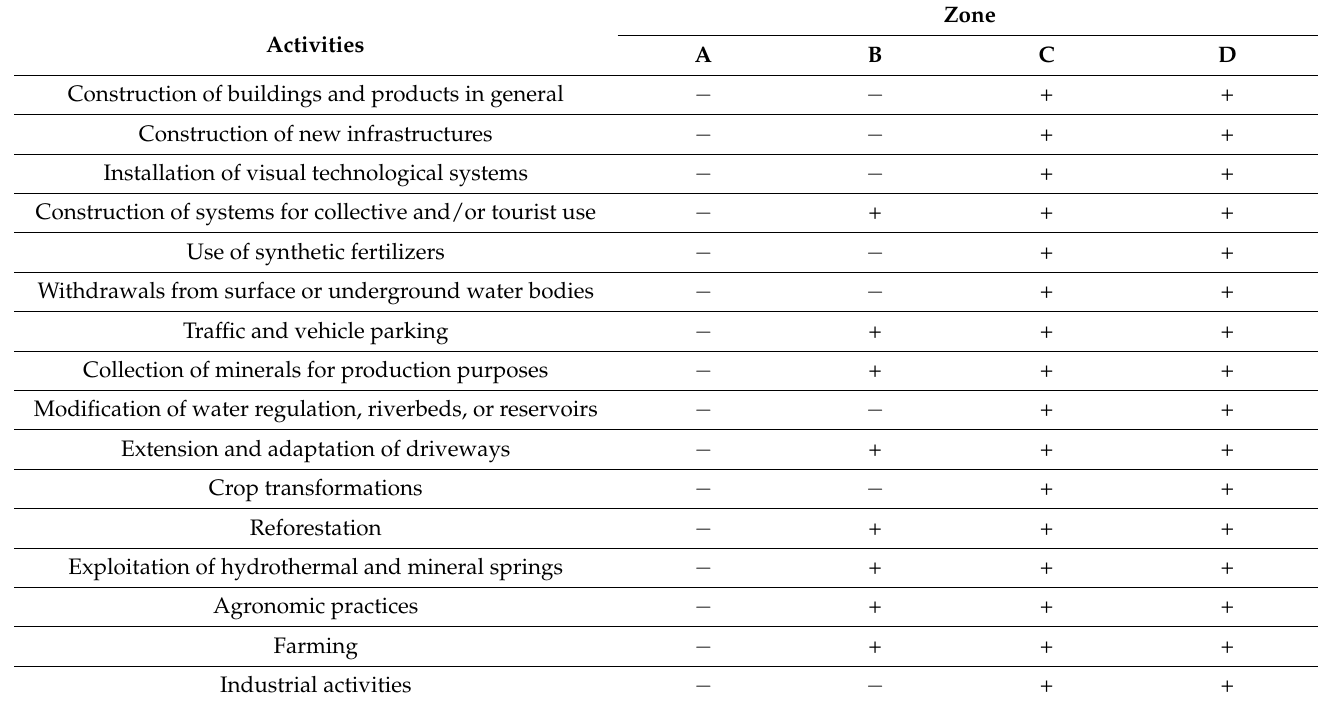
Table 7. Activities that can be implemented for the establishment of the park and positive or negative prescriptions for the individual homogeneous areas (+ permitted activity, − prohibited